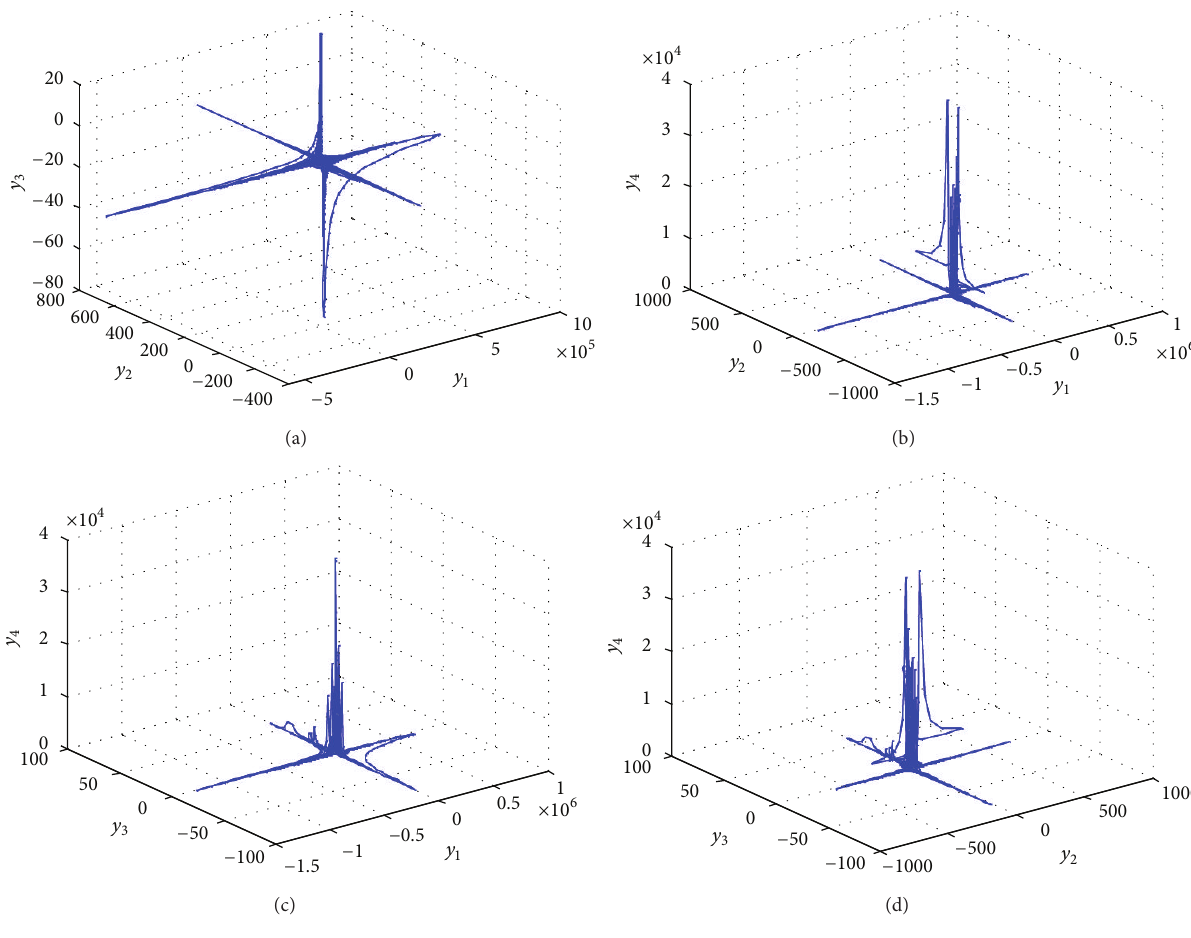
Figure 2: Projections of the phase portrait for chaotic system (13) of Case